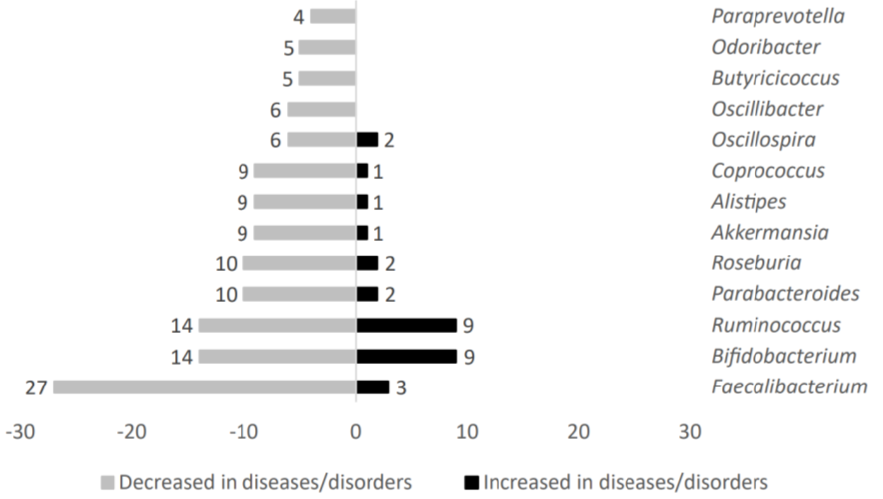
Figure 2. Analysis of main taxa stratified according to high representativeness in patients without metabolic-related diseases.